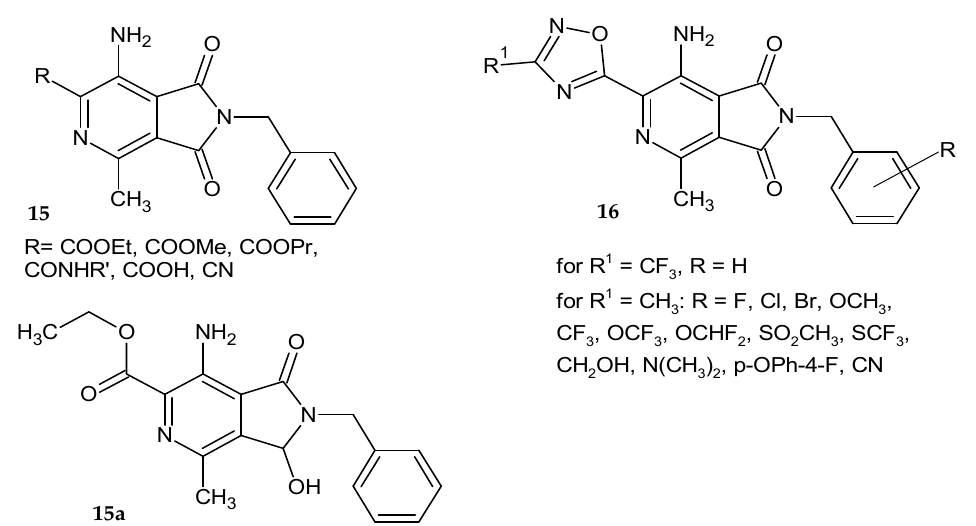
Figure 11. 7 ‐ Amino ‐ 2 ‐ benzyl ‐ 4 ‐ methyl ‐ pyrrolo[3,4 ‐ c ]pyridine ‐ 1,3 ‐ dione derivatives 15–16 with an antimycobacterial activity and the most active compound 15a .